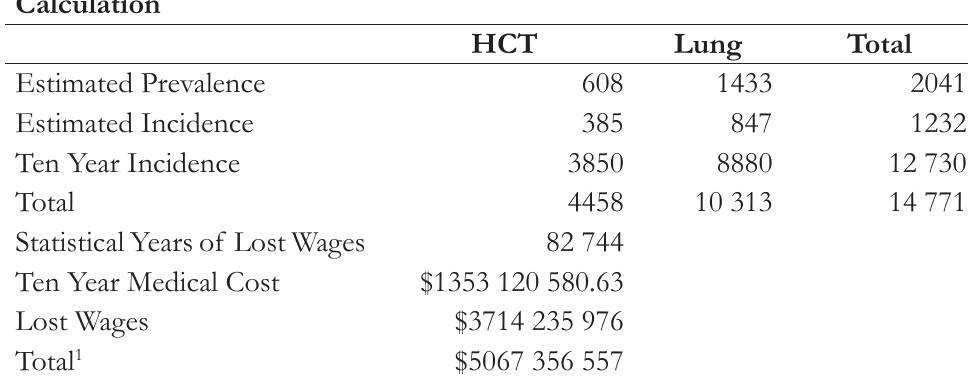
Table 1. Present and 10-year Burden of Cost for